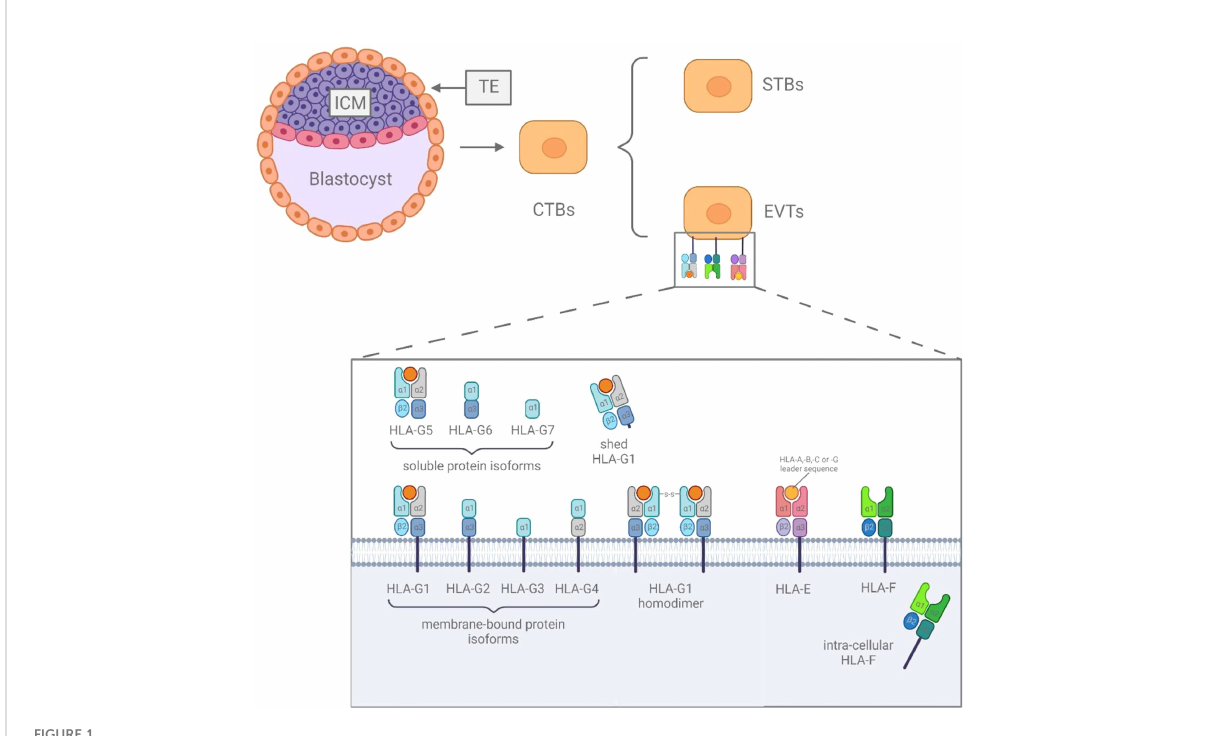
FIGURE 1 The difference among HLA class